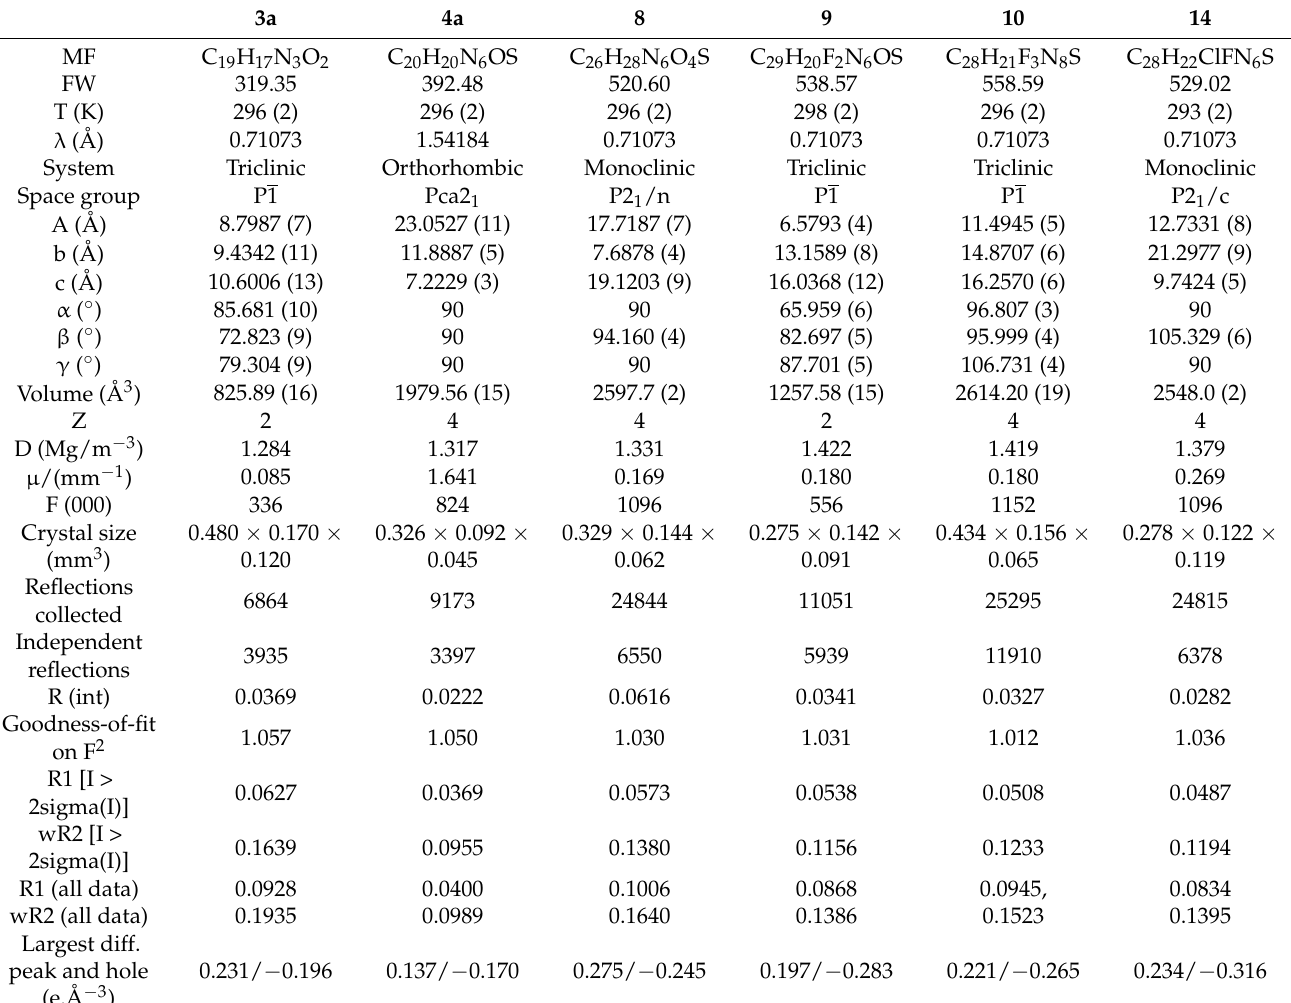
Table 1. Data collection and refinement data for compounds 3a , 4a , 8 – 10 , and 14 .